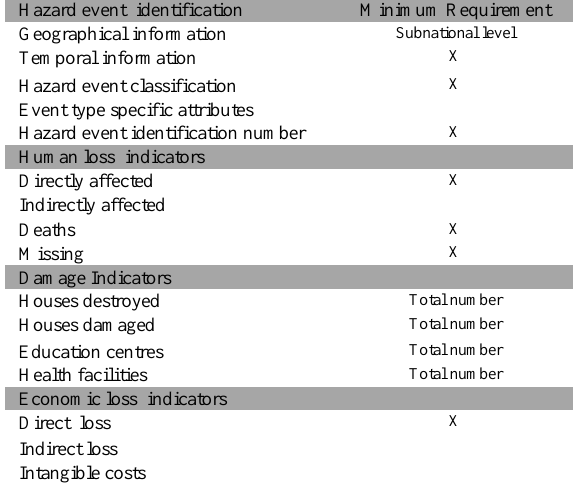
Table 1. The primary indicators of the disaster damage and loss database and the minimum requirements for loss-data